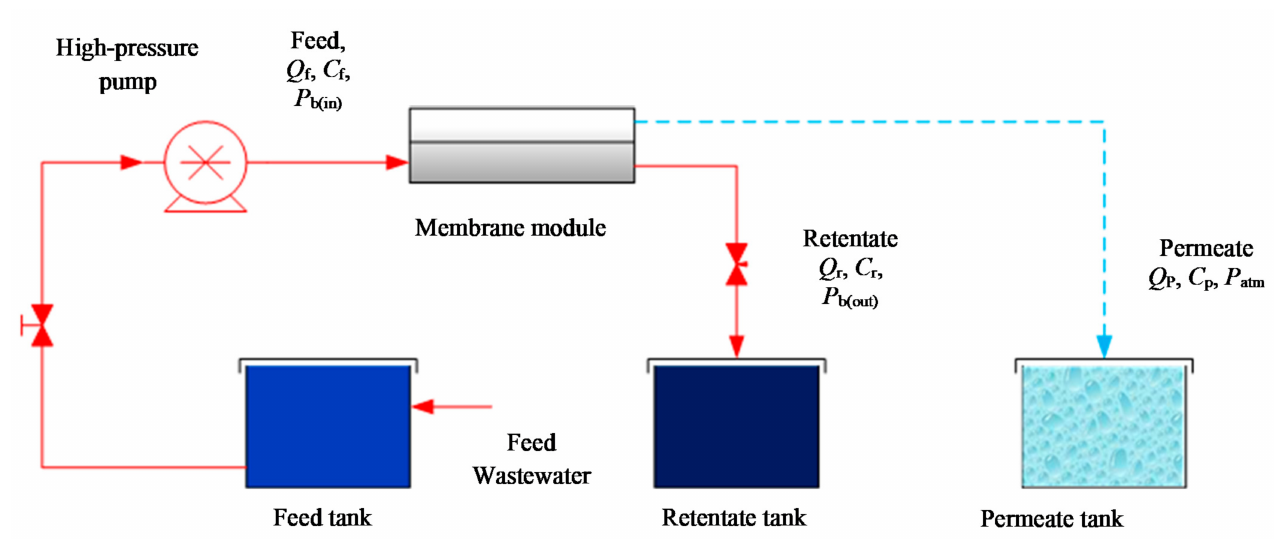
Figure 1. A detailed diagram of a single spiral wound membrane module of RO